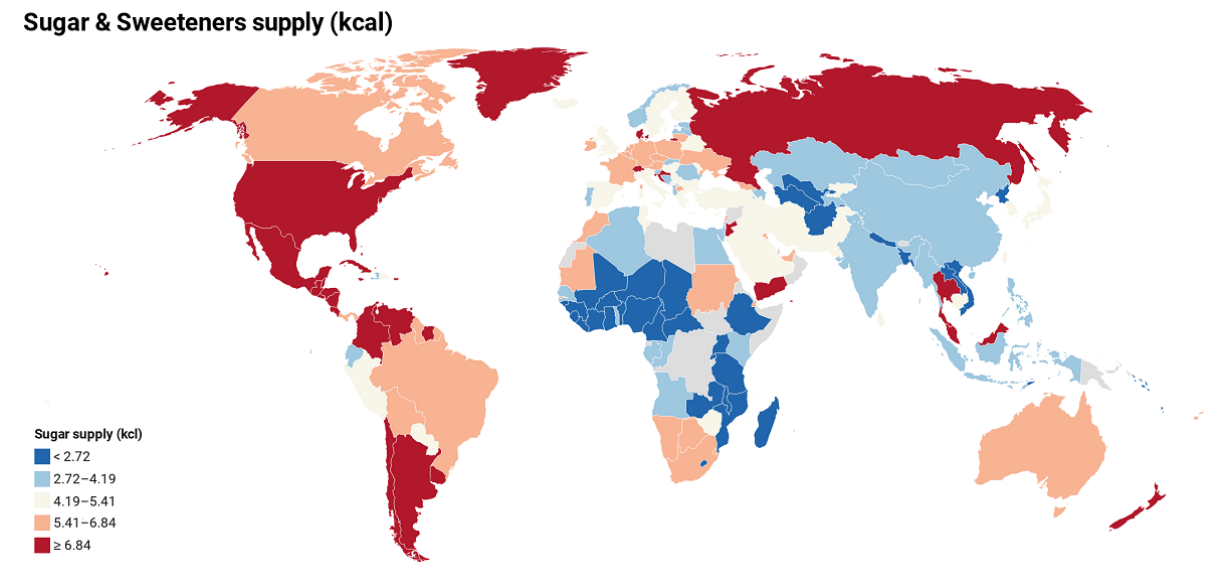
Figure 2. World map related to sugar and sweeteners supply